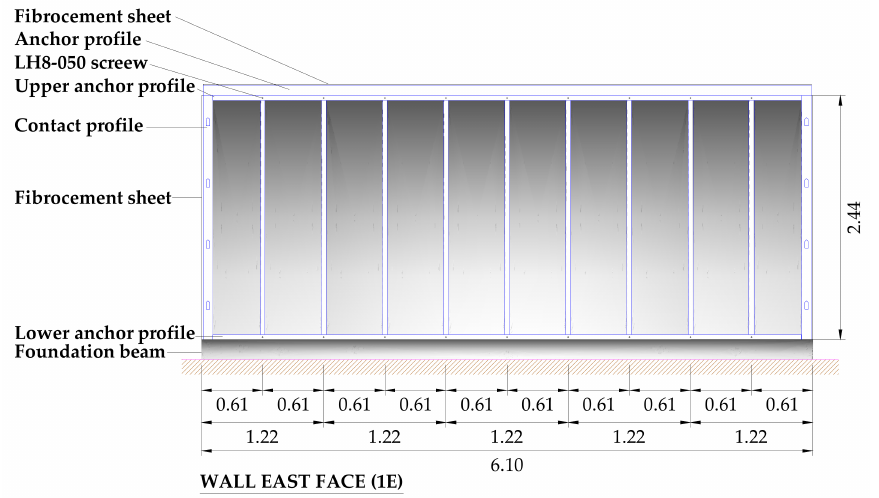
Figure 2. Wall 1 of the experimental specimen at full-scale (east face).